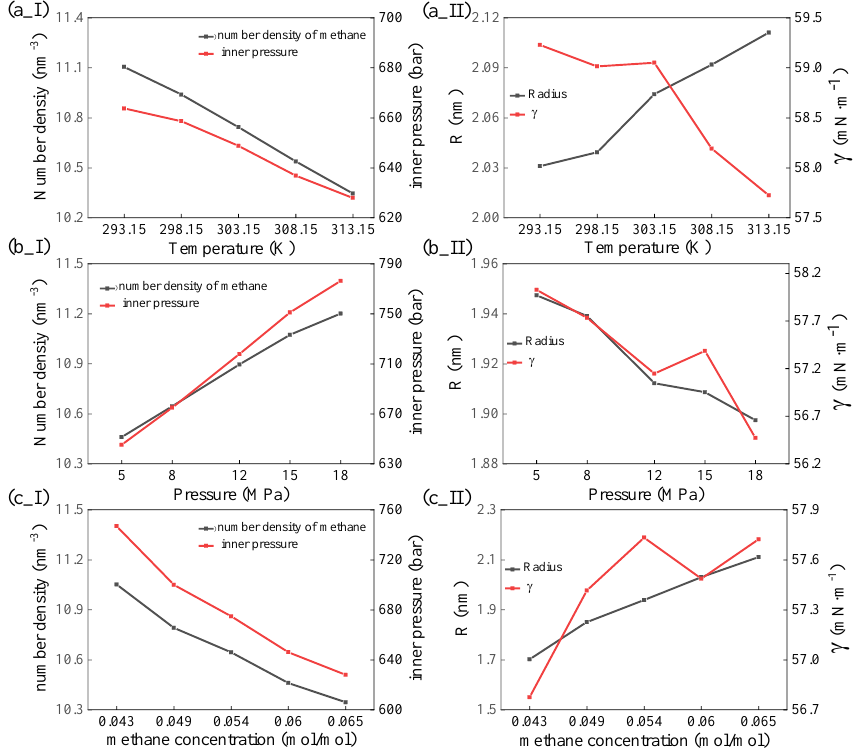
Figure 4. ( I ) Methane number densities and the inner pressures in the bulk of bubbles and ( II ) radii and surface tensions of the bubbles in ( a ) Sys6_8MPa at different temperatures, ( b ) Sys4 at 313.15 K and at different pressures, and ( c ) systems with different X methane values at 313.15 K and 8 MPa.